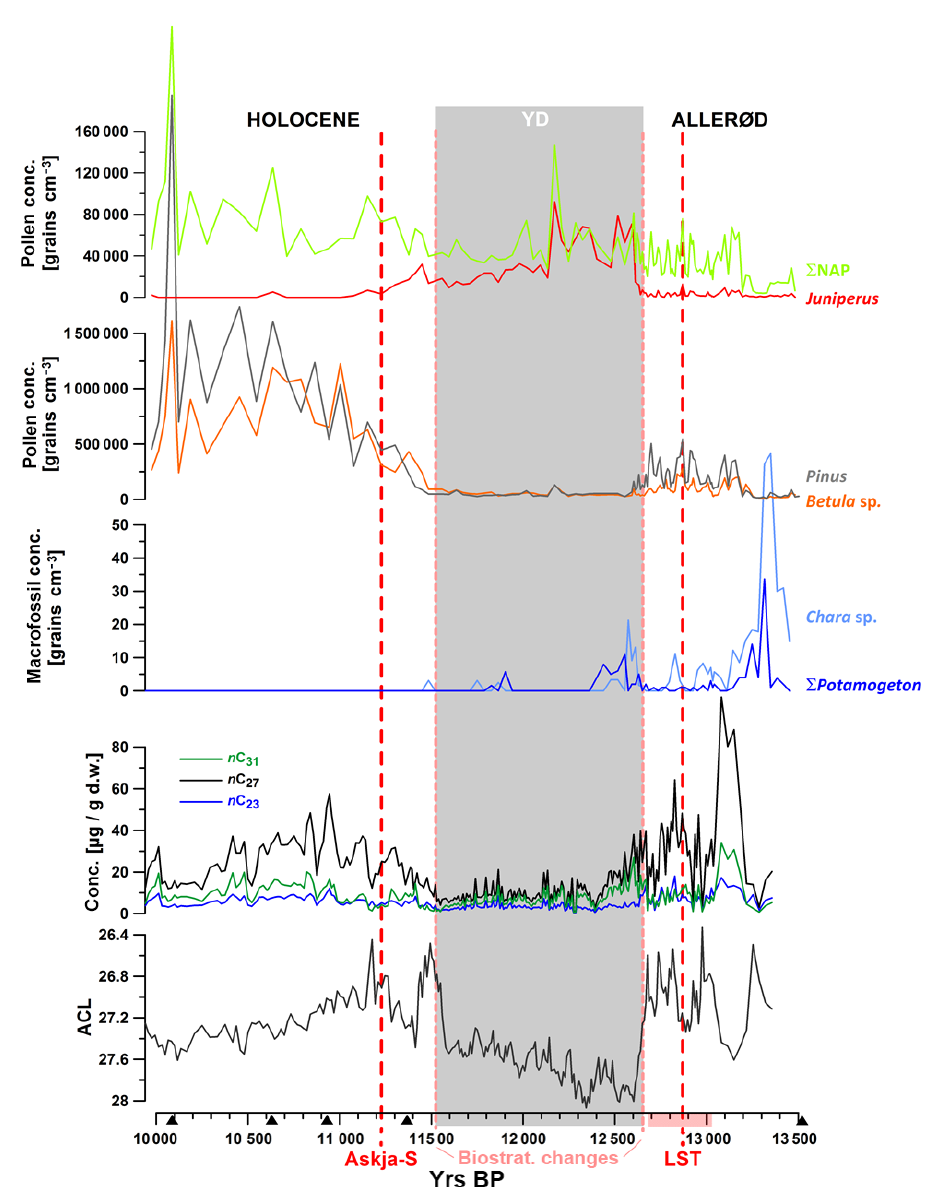
Figure 3. n -Alkane concentrations and average chain lengths (ACLs) during the studied interval in comparison to pollen and macrofossil counts (Wulf et al., 2013; Słowinski et al., 2017; unpublished macrofossil data from 10000–12400yrBP). NAP: non-arboreal pollen. Grey shaded interval: YD according to pollen